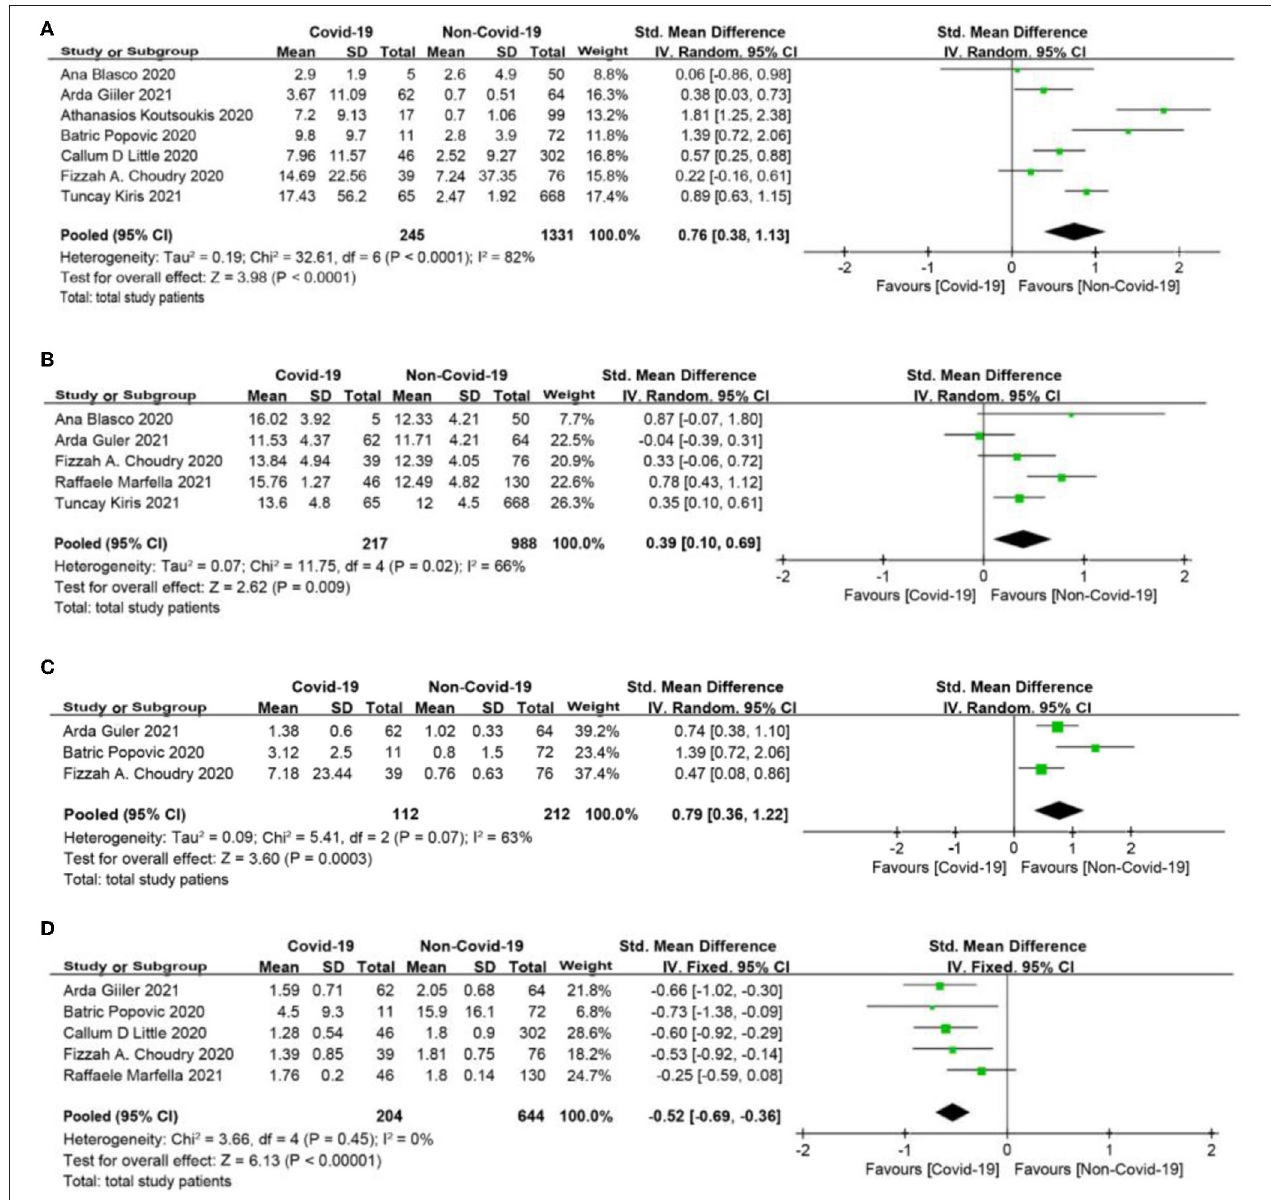
FIGURE 3 | (A) C-reactive protein (CRP) forest plot (mg/dl). (B) White blood cell ( WBC) forest plot (*10 9 /L). (C) D-dimer forest plot (mg/L). (D) Lymphocyte count forest plot (*10 9